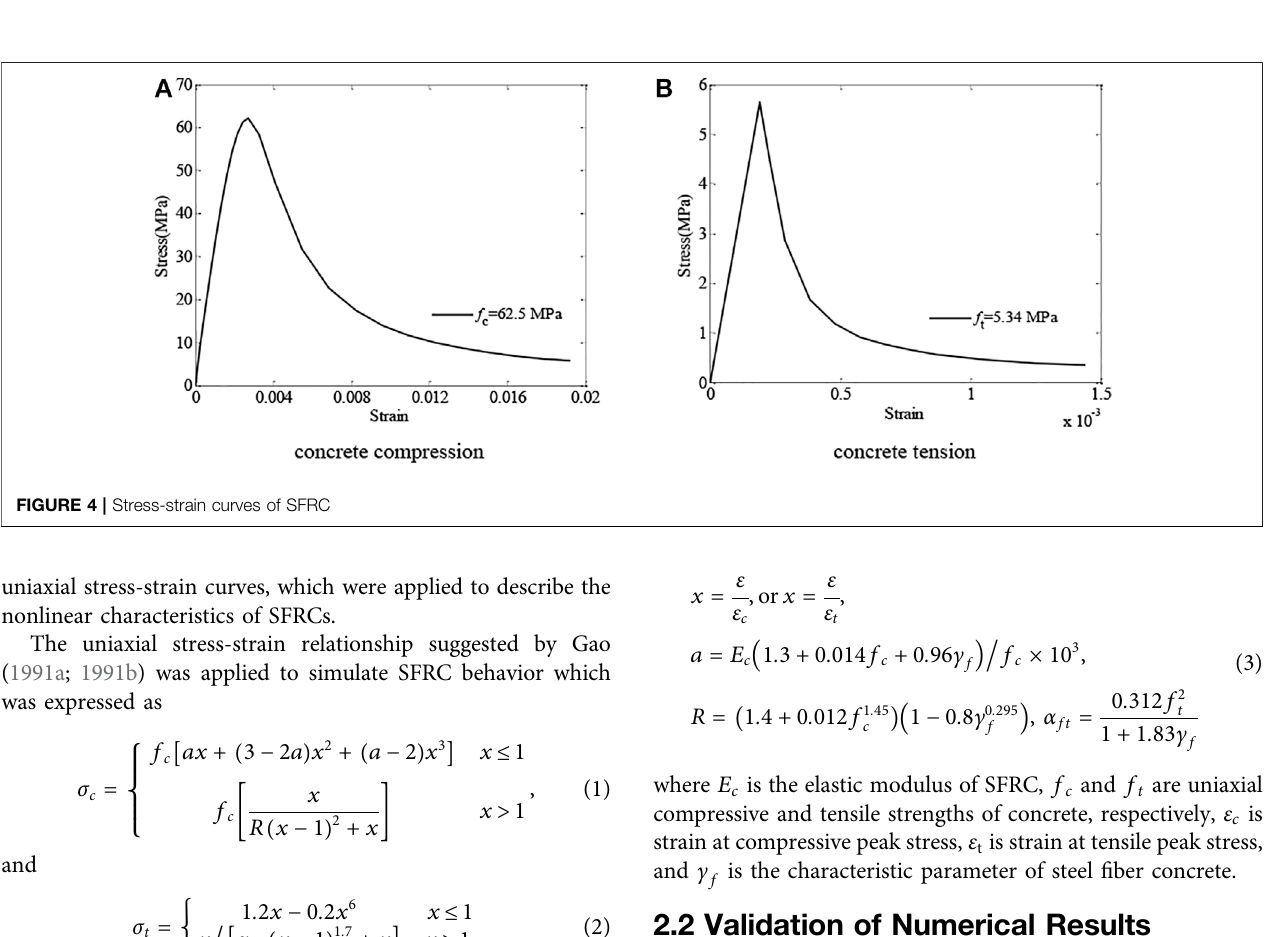
FIGURE 3 | Boundary conditions and loading surfaces.